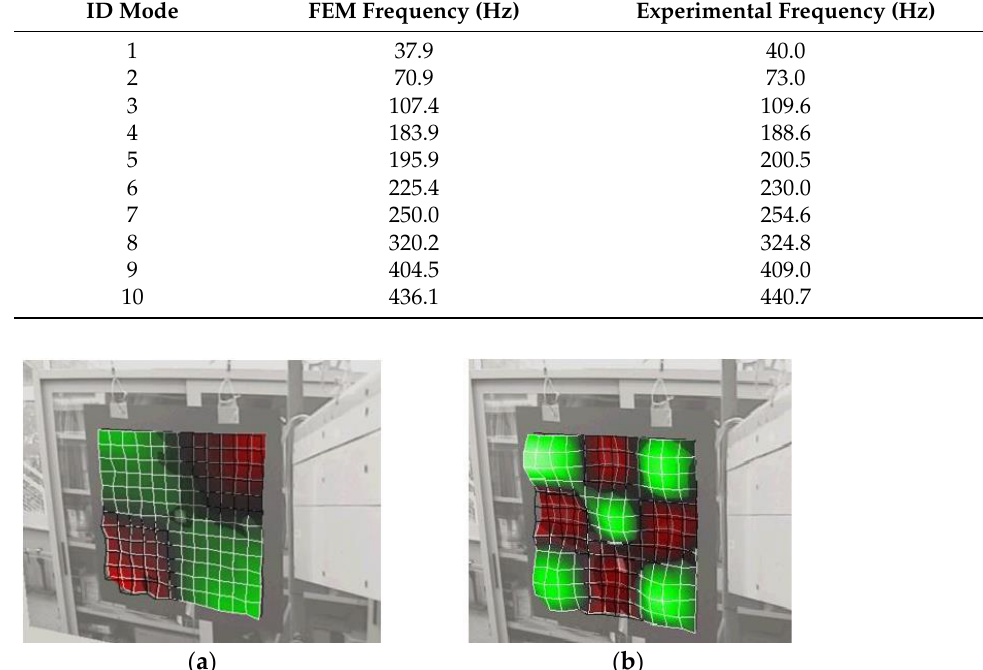
Figure 7. Operational Deflection Shapes (ODS) by laser vibrometry technique: ( a ) basic and ( b ) more complex shape.